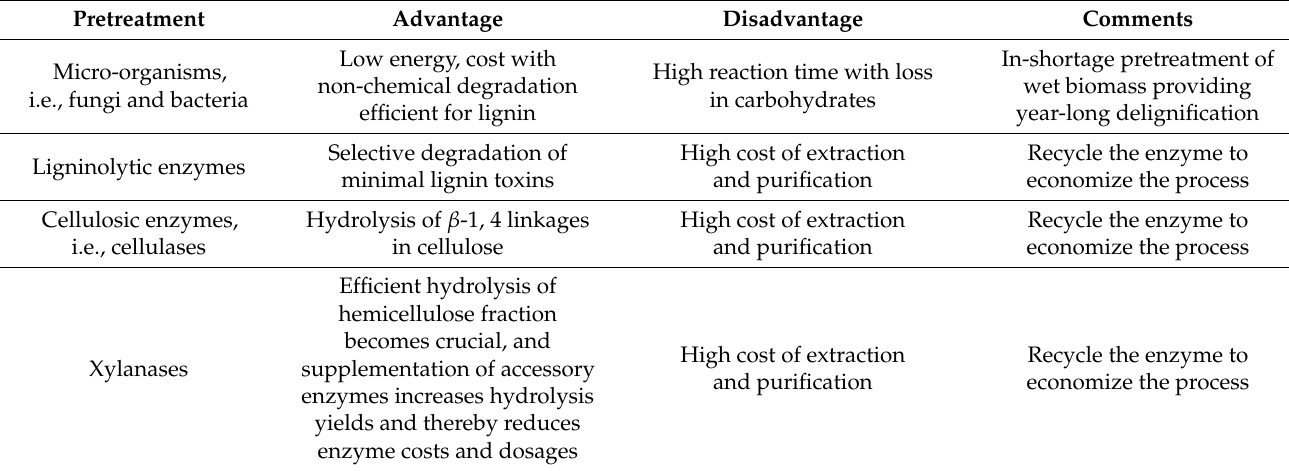
Table 3. Biological pretreatment techniques and their possible